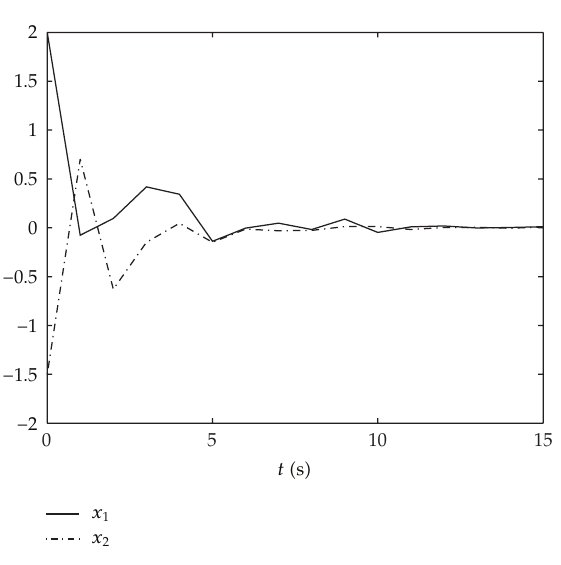
Figure 1: The state response x (cid:3) k (cid:4)